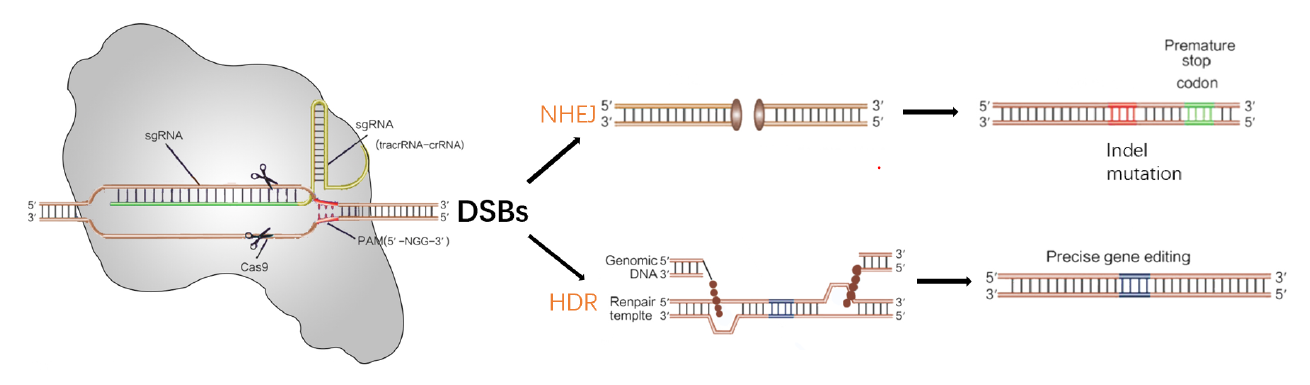
Figure 1. Gene editing mechanisms of the CRISPR/Cas9 system. DSBs (DNA double-stranded breaks) induced by Cas9 (brown) can be repaired in one of two ways: the non-homologous end joining (NHEJ) pathway or the homology-directed repair (HDR) pathway.